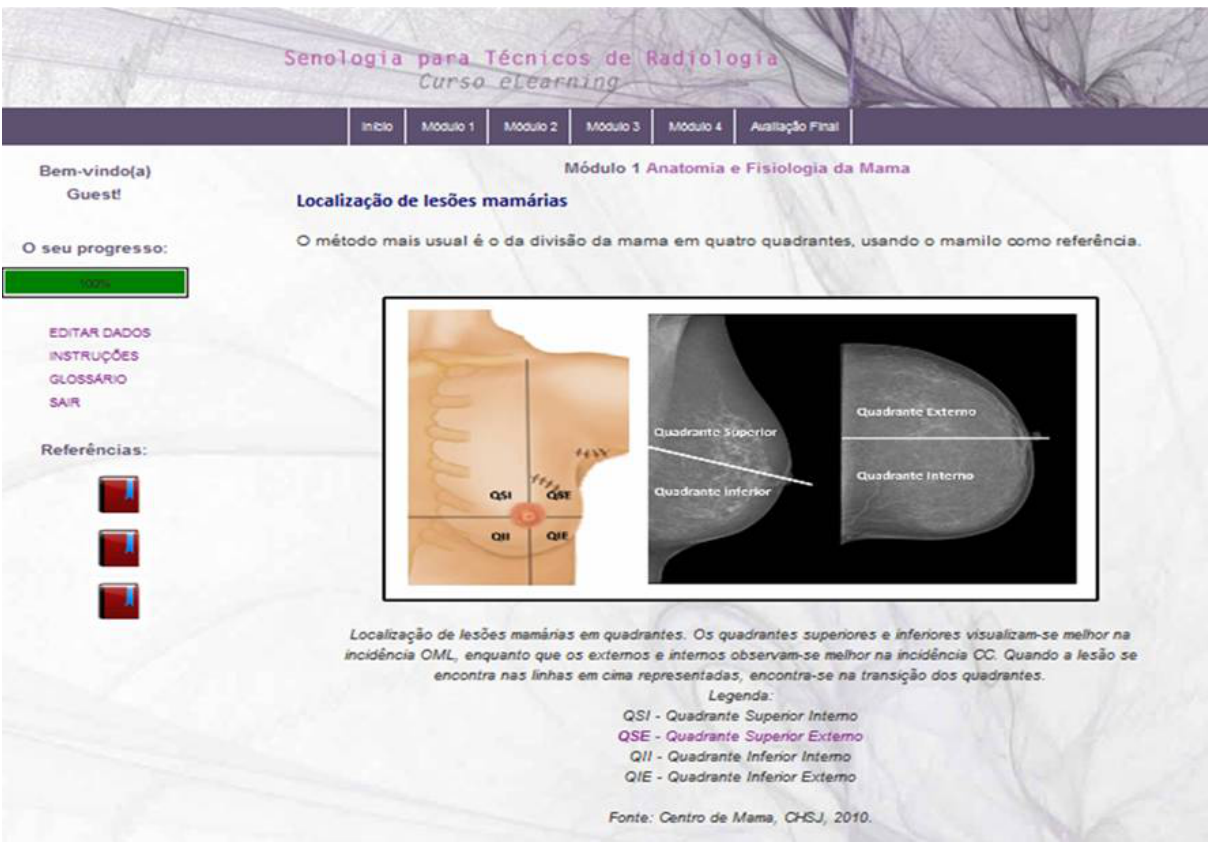
Figure 4. Screenshot of mammography views and schemes in the e-learning course.